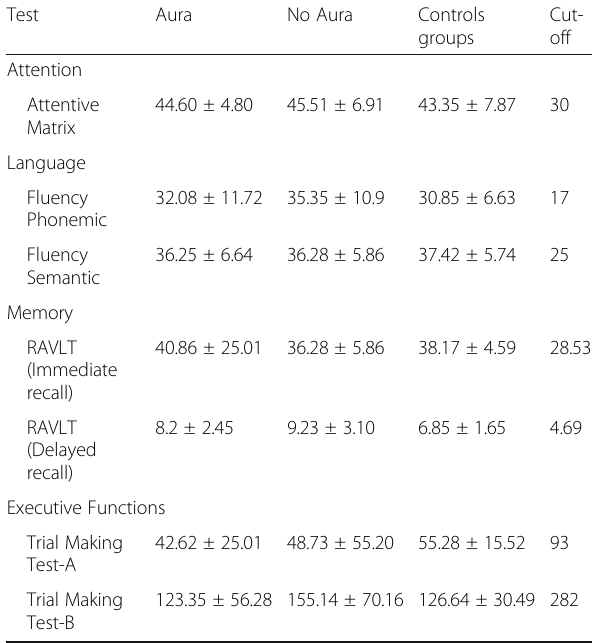
Table 2 Cognitive performances of the migraine